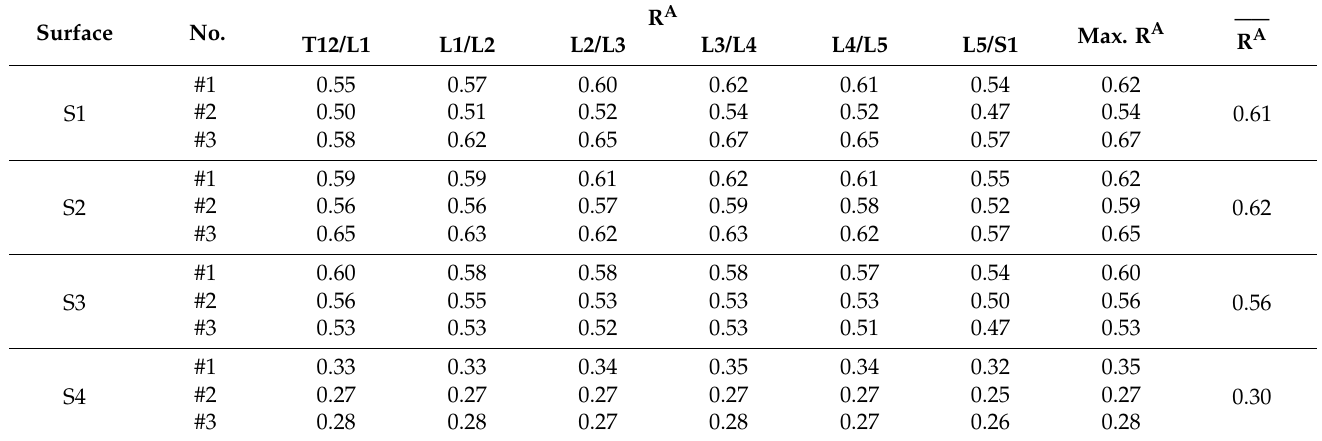
Table 10. Summary of data obtained from driver 1 according to ISO 2631-5:2018, Factor R A . Surface